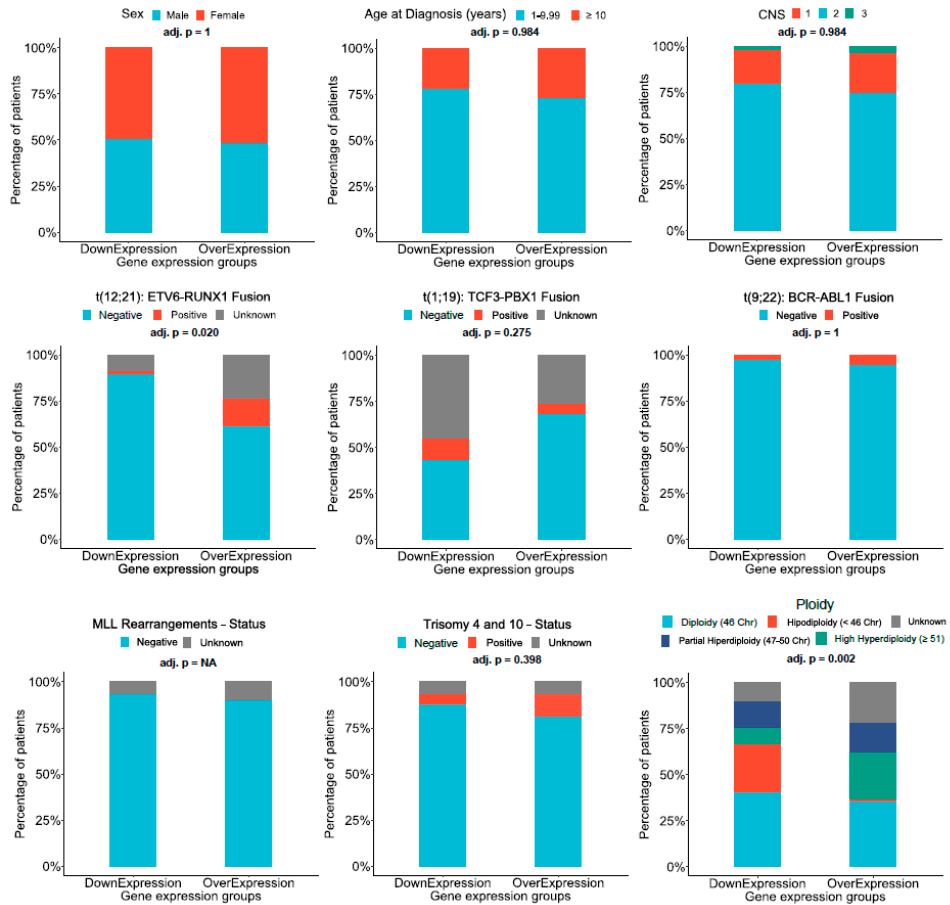
Figure A2. Comparison of AL133346.1 and CCN2 expression between di ff erent karyotypes of pediatric B-ALL patients from our own microarray ( a ) and di ff erent subtypes of pediatric B-ALL patients from TARGET ( b ) . The boxplots are colored according to the ALL subtype. The BCR-ABL and MLL subtypes had 3 and 0 positive samples respectively, thus they were excluded from the boxplot. Sample sizes: [TCF3 ‐ PBX1]: 7; Trisomy 4–10: 10; [ETV6 ‐ RUNX1]: 10.